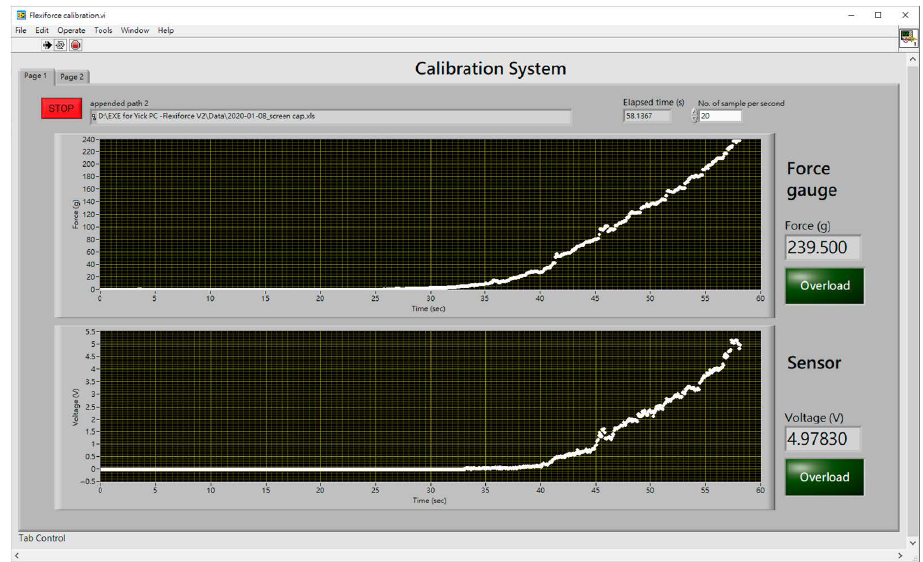
Figure 5. Control panel for sensor calibration.